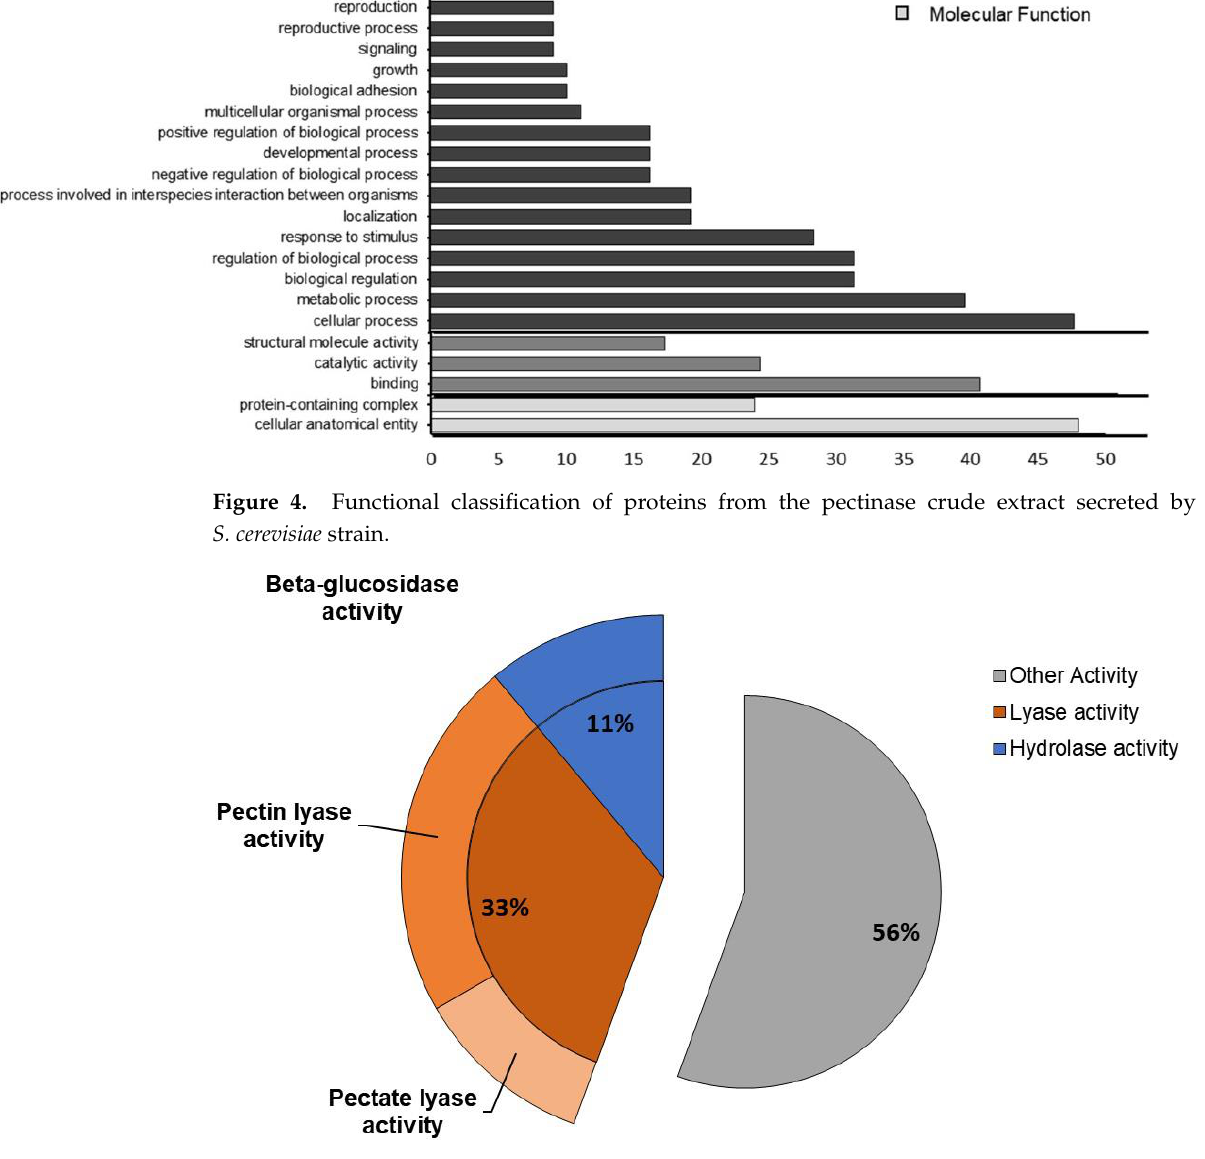
Figure 4. Functional classification of proteins from the pectinase crude extract secreted by S. cere- visiae strain.